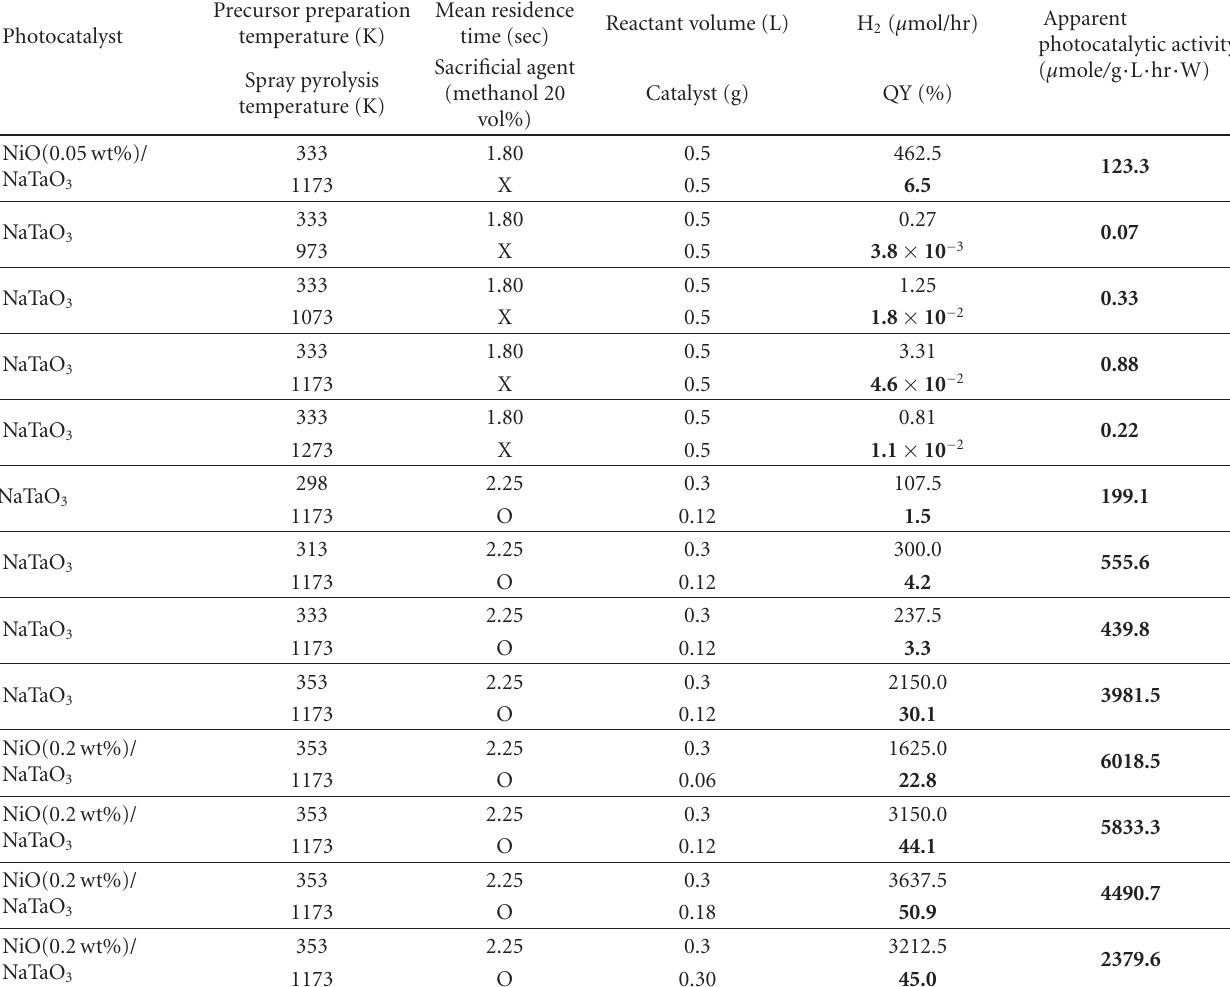
Table 4: Quantum yield (QY) obtained by (1) and apparent photocatalytic activity (APA) obtained by (2) of photocatalysts in the present study for water splitting (reactor, Pyrex cylinder; lamp, 15W UV-C lamp; actinometer, potassium